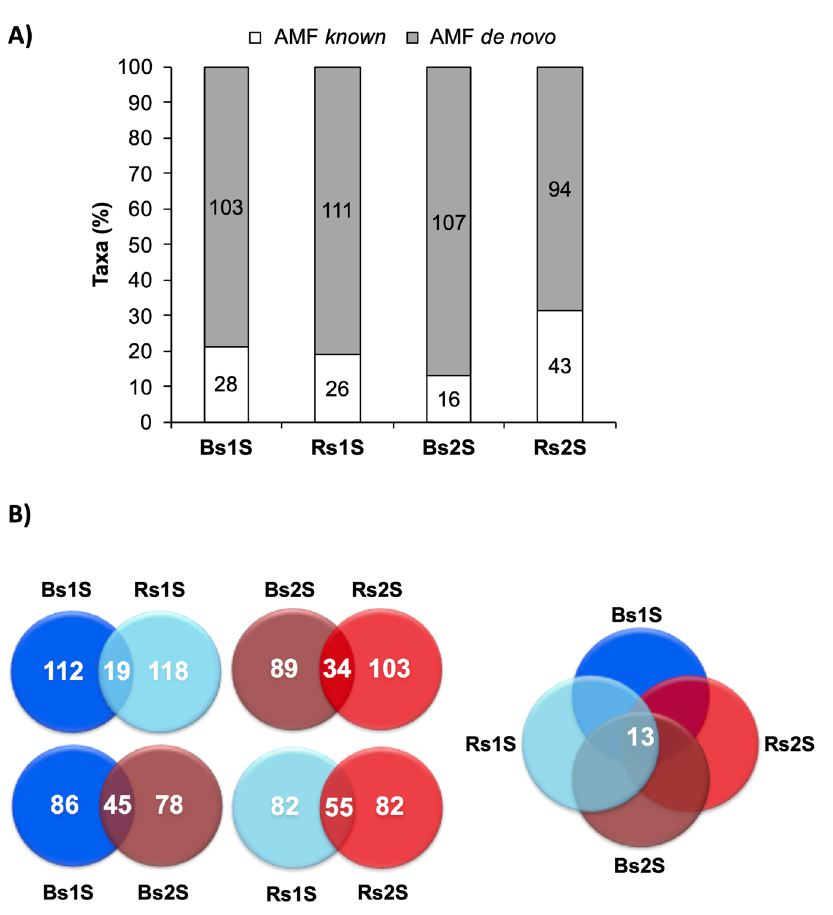
Figure 2. A) Taxa richness . Taxa obtained from Bulk soil (Bs) and the soil associated with the roots of V. vinifera cv. Pinot Noir (Rs) during the two sampling times (1 S = flowering and 2 S = fruit development). Bars represent the percentage, while labels inside the bars indicate the real number of taxa of “AMF known” (white) and “AMF de novo ” (grey). B) Venn diagrams . Venn diagrams representing the number of taxa, that were exclusive or common to: a) Bulk soil (Bs) and the soil associated with the roots of V. vinifera cv. Pinot Noir (Rs) in the first (1 S) or in the second (2 S) sampling time (upper part on the left of the figure); b) the first (1 S) and the second (2 S) sampling times in Bs or in Rs (lower part on the left of the figure); c) the four soil samples (Bs1S, Rs1S, Bs2S, Rs2S - on the right of the figure). The Venn diagrams were drawn using the freely available Venny version 2.1 software